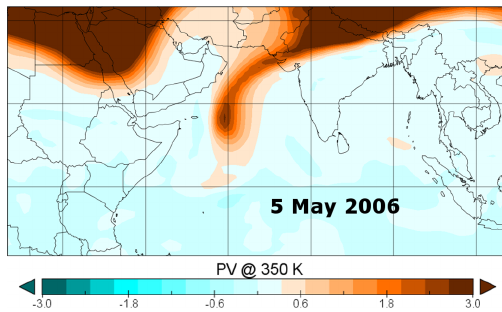
Figure 13. Potential vorticity from